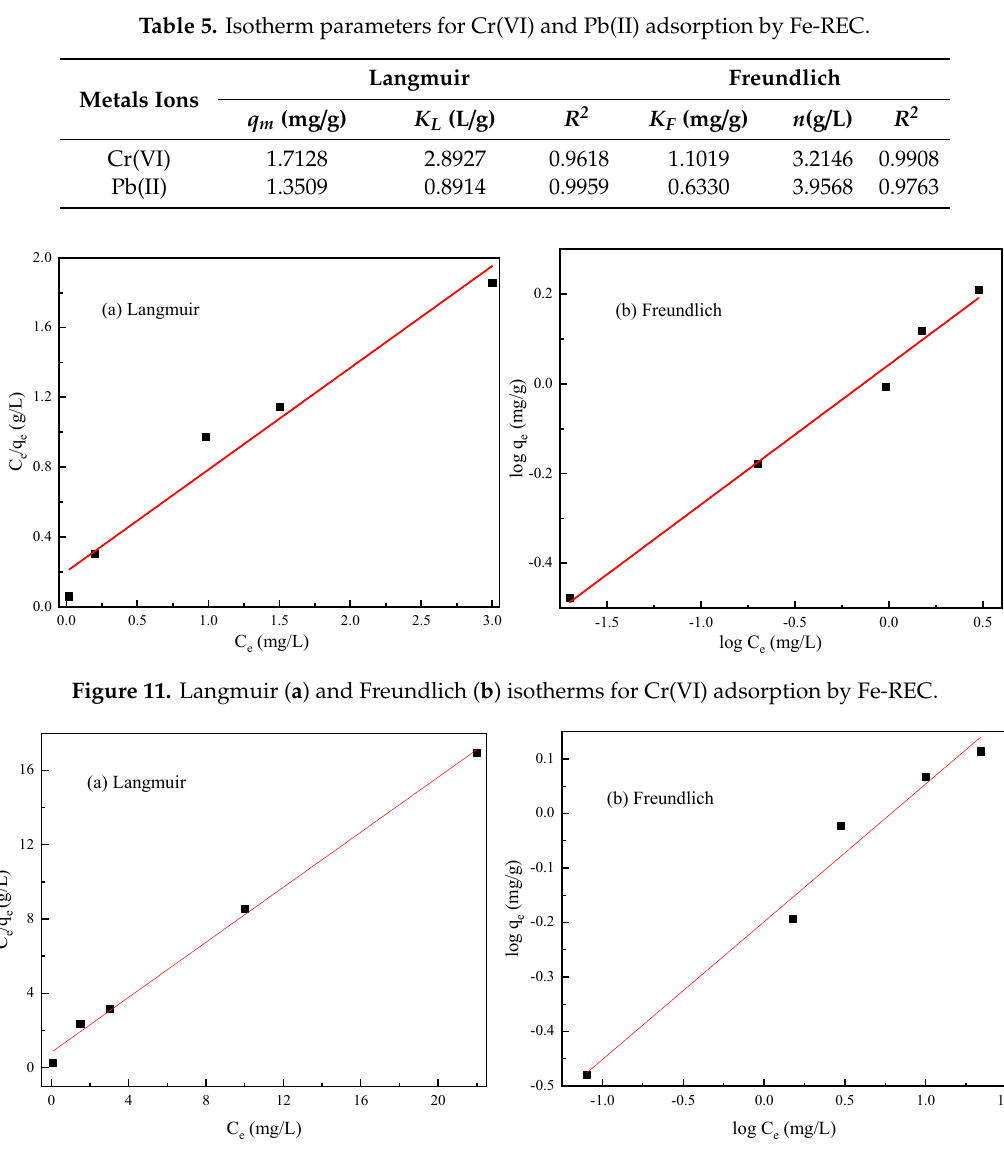
Figure 12. Langmuir ( a ) and Freundlich ( b ) isotherms for Pb(II) adsorption by Fe-REC.